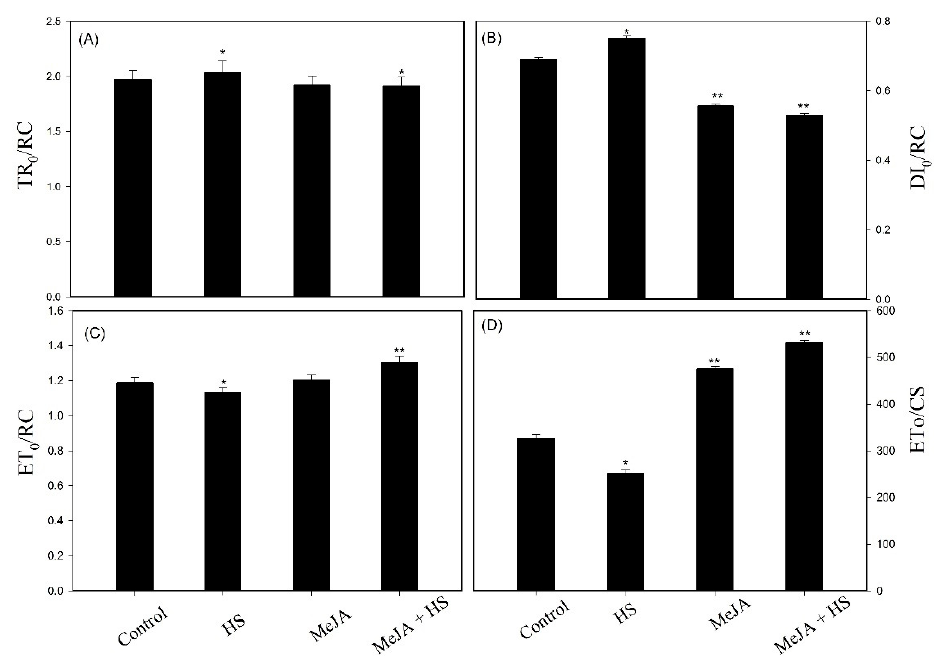
Figure 3. Photosynthetic parameters inferred from the JIP test study of chlorophyll fluorescence transients. Change of specific energy fluxes per PS II reaction center (RC) as ( A ) Trapping (TR 0 /RC), ( B ) Dissipation (DI 0 /RC), and ( C ) Electron transport (ET 0 /RC) and for ( D ) yields as quantum yields of electron transport (ET o /CS) in wheat leaves at 30 DAS. Plants were treated with MeJA (10 µ M) at 42 ◦ C (heat stress) or 25 ◦ C (no stress). Data are presented as mean ± SE ( n = 4). Significantly different values between control and treatments are marked with an asterisk (* p < 0.05, ** p < 0.01), as determined by Tukey’s test. DAS, days after sowing; HS, heat stress; MeJA, methyl